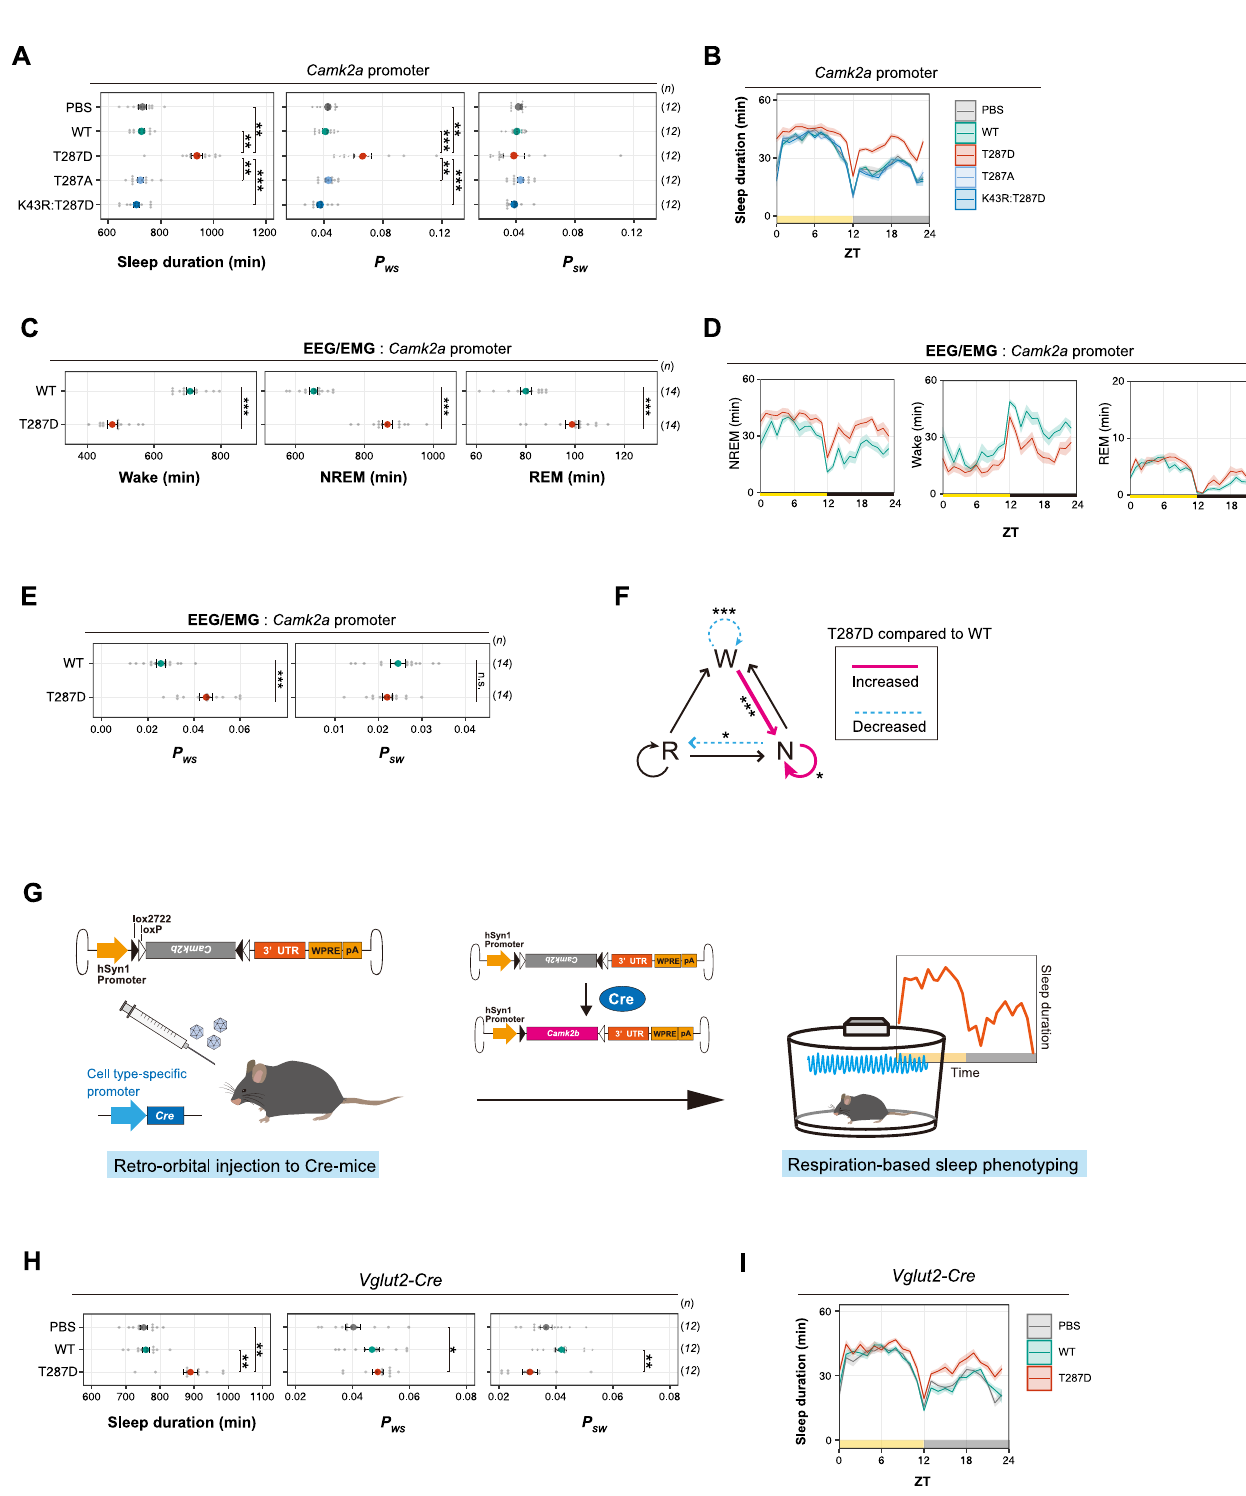
Fig 3. Phosphorylation of CaMKII β in excitatory neurons regulates sleep induction. (A, B) Sleep/wake parameters (A) and sleep profiles (B) of mice expressing CaMKII β T287-related mutants under the Camk2a promoter, averaged over 6 days. Shaded areas represent SEM. Multiple comparison tests were performed between all individual groups. (C-E) Sleep phenotypes (C and E) and sleep profiles (D) measured by EEG/EMG recordings for mice expressing CaMKII β (WT) or the T287D mutant under the Camk2a promoter. (F) Differences in transition probabilities (between wakefulness (W), NREM sleep (N), and REM sleep (R)) between mice expressing WT CaMKII β or the T287D mutant under the Camk2a promoter. Magenta lines and dashed blue lines indicate when the values for the T287D-expressing